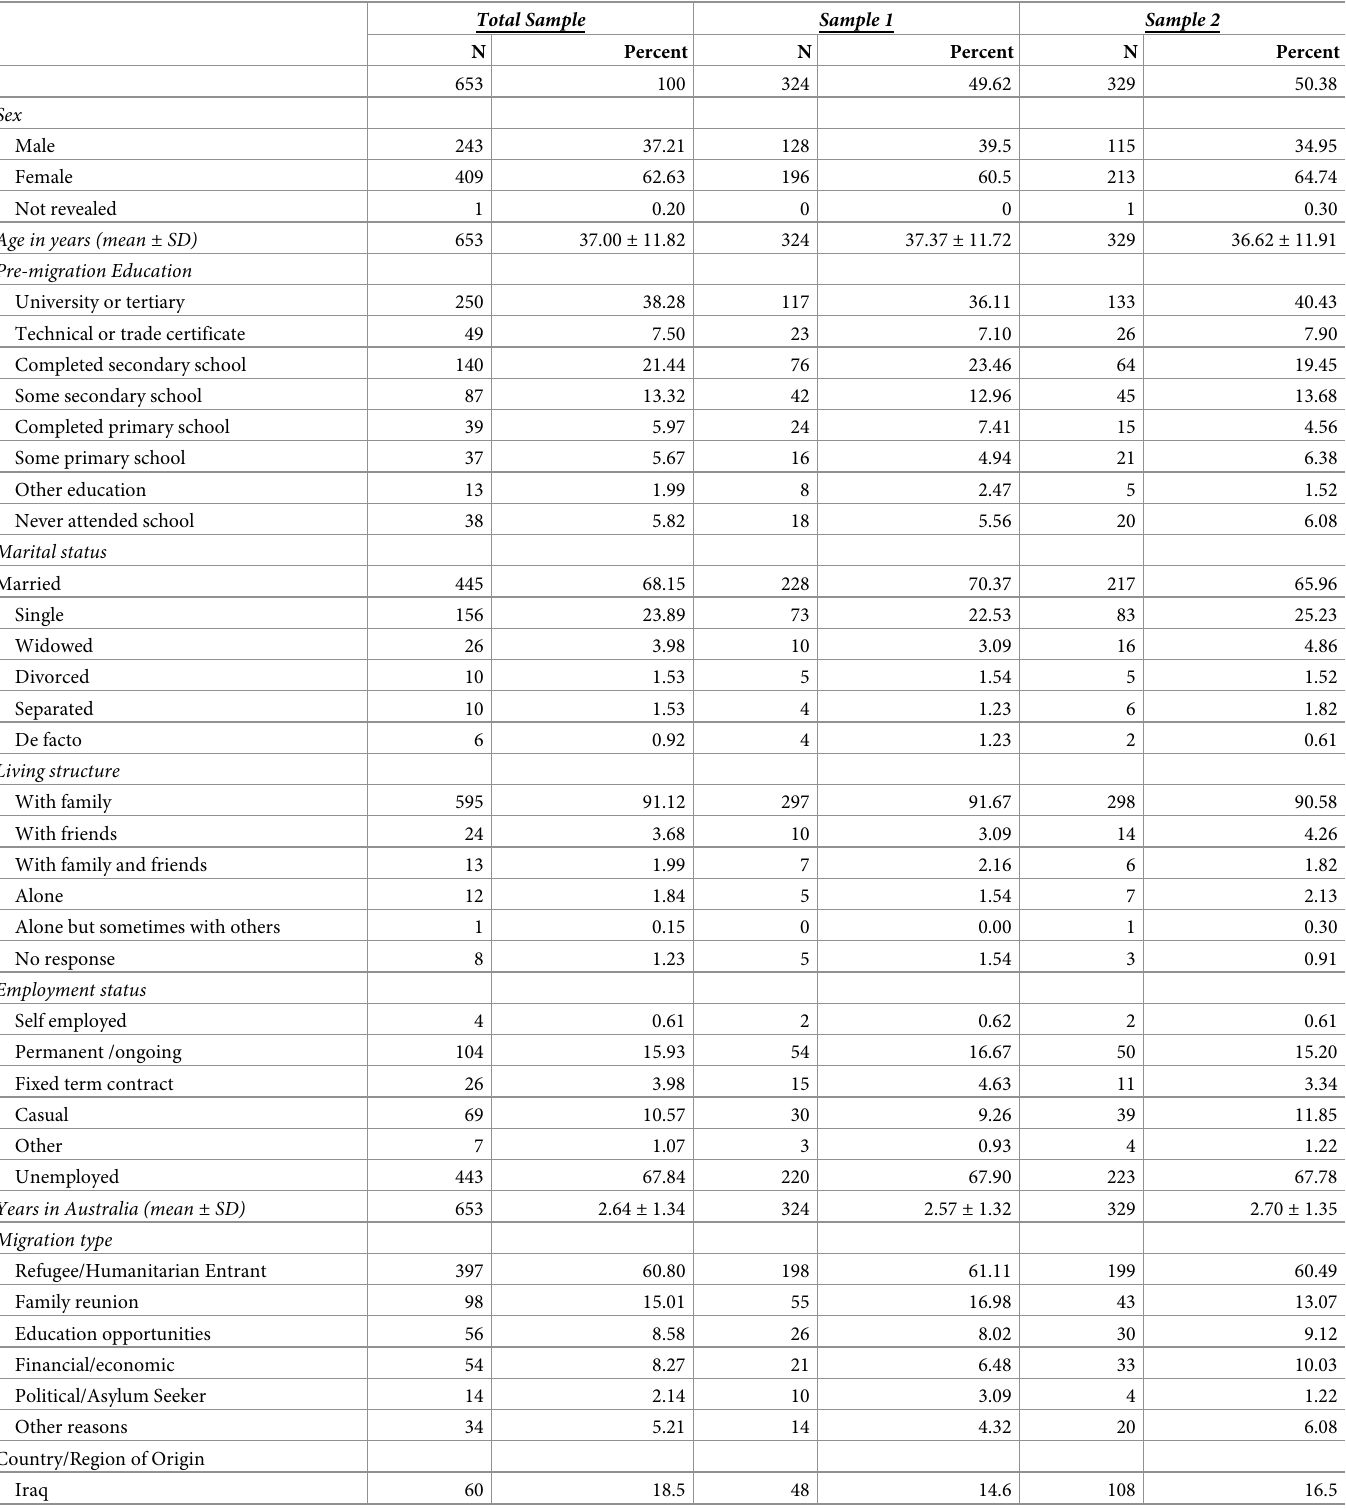
Table 2. Demographic characteristics of the two split-half